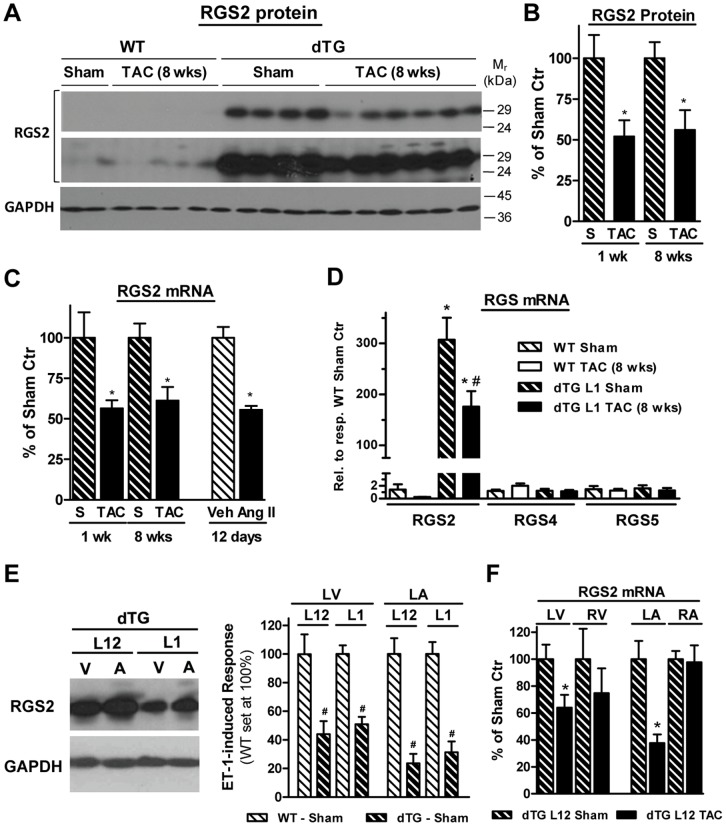
TAC and Ang II induce chamber-specific down-regulation of transgenic RGS2 protein and mRNA.[A] Representative Western blot of crude ventricular homogenates (60 µg/lane) from WT and dTG (L1) ventricles after sham or 8 wk TAC, which were probed with antibodies recognizing RGS2 (1 and 10 sec exposure times) and GAPDH. [B] Ventricular RGS2 protein downregulation in dTG mice (L1, conditional transgene expression) after TAC for 1 wk (n = 9) or 8 wks (n = 15) compared to respective sham controls (n = 7–9). * P<0.05 TAC vs Sham. [C] Ventricular RGS2 mRNA downregulation in dTG mice (L1, conditional transgene expression) after TAC for 1 wk (n = 6) or 8 wks (n = 12) compared to respective sham controls (n = 6–8). The effect of Ang II infusion (n = 4) compared to vehicle controls (n = 2) for 12 days is also shown. * P<0.05 TAC vs Sham or Ang II vs vehicle respectively. [D] Ventricular RGS2, RGS4 and RGS5 mRNA expression in WT and dTG (L1) mice 8 wks after TAC or sham operation. Real-time PCR data normalized to 18S are expressed relative to respective WT sham (n = 7–10 in each group, except for n = 3 for RGS2 in WT). [E] Left: Representative Western blot of crude homogenates (30 µg/lane) of L12 and L1 dTG ventricles (V) and atrial appendages (A) probed with antibodies recognizing RGS2 and GAPDH. Right: Inhibition of ET-1-induced IP formation in left atrial appendages (LA) and ventricles (LV) from sham-operated L12 (n = 6–7) and L1 (n = 5) dTG. Data are expressed in % of the ET-1-induced response in WT (set at 100%, not shown). # P<0.05 dTG vs WT (set at 100%). [F] RGS2 mRNA expression in left and right ventricles and atrial appendages from dTG L12 mice (constitutive transgene expression) 10 days after TAC compared to respective sham controls (n = 5–7). * P<0.05 TAC vs Sham.